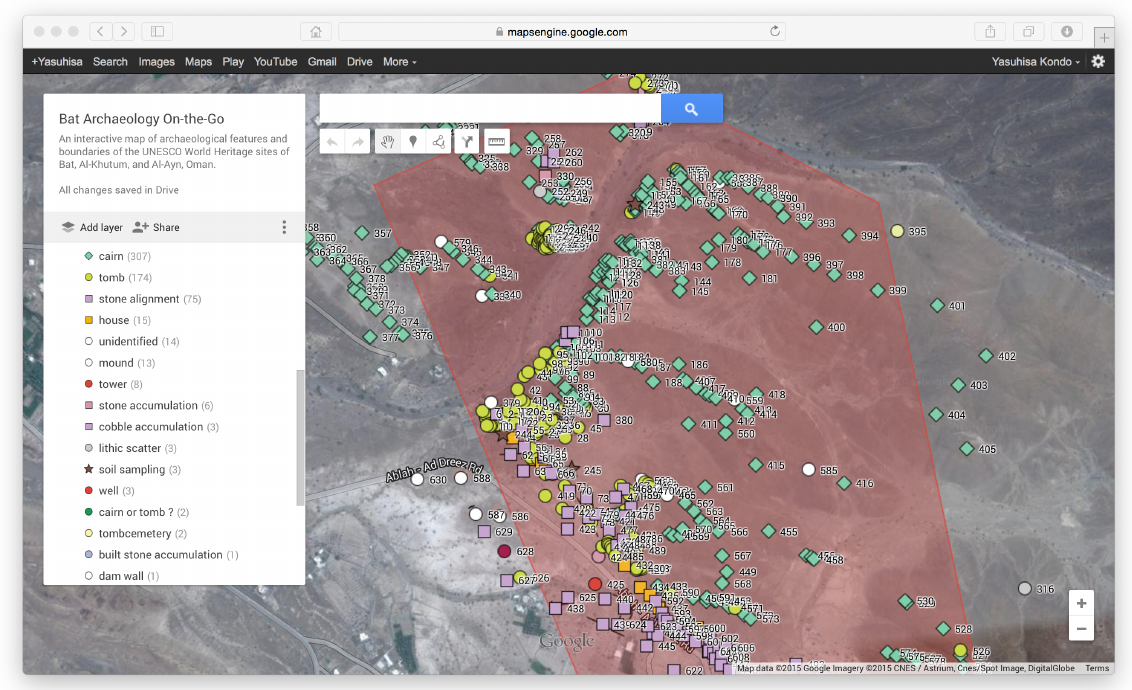
Figure 9: A Google Maps Engine interactive map of the BatDHI, showing the spatial distribution of archaeological features in and around the UNESCO area (red).